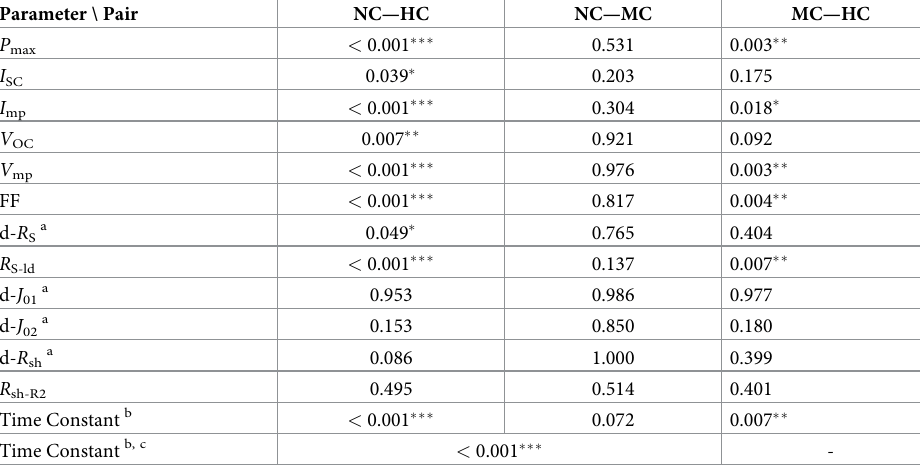
Table 1. p -Values in multiple-comparison (Steel-Dwass test). Parameter \